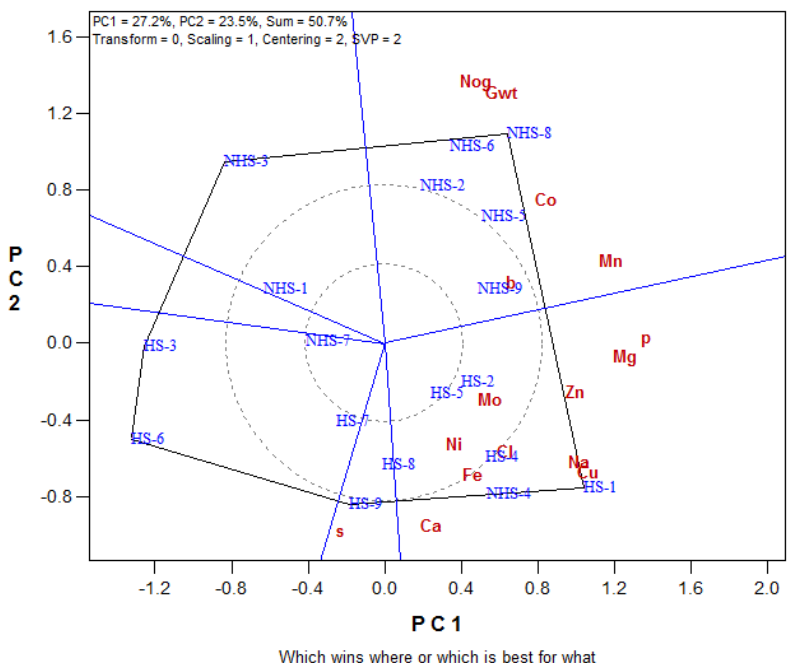
Figure 1. The which ‐ won ‐ where biplot view of the treatment interactions and the attributes. HS— Figure 1. The which-won-where biplot view of the treatment interactions and the heat ‐ stressed environment, NHS—non ‐ heat ‐ stressed environment, 1—WE3128 with MF, 2— WE3128 with MPM, 3—WE3128 with PM, 4—WE5323 with MF, 5—WE5323 with MPM, 6—WE5323 with PM, 7—ZM1523 with MF, 8—ZM1523 with MPM, 9—ZM1523 with PM, GWt — grain weight, and NoG—number of grain.